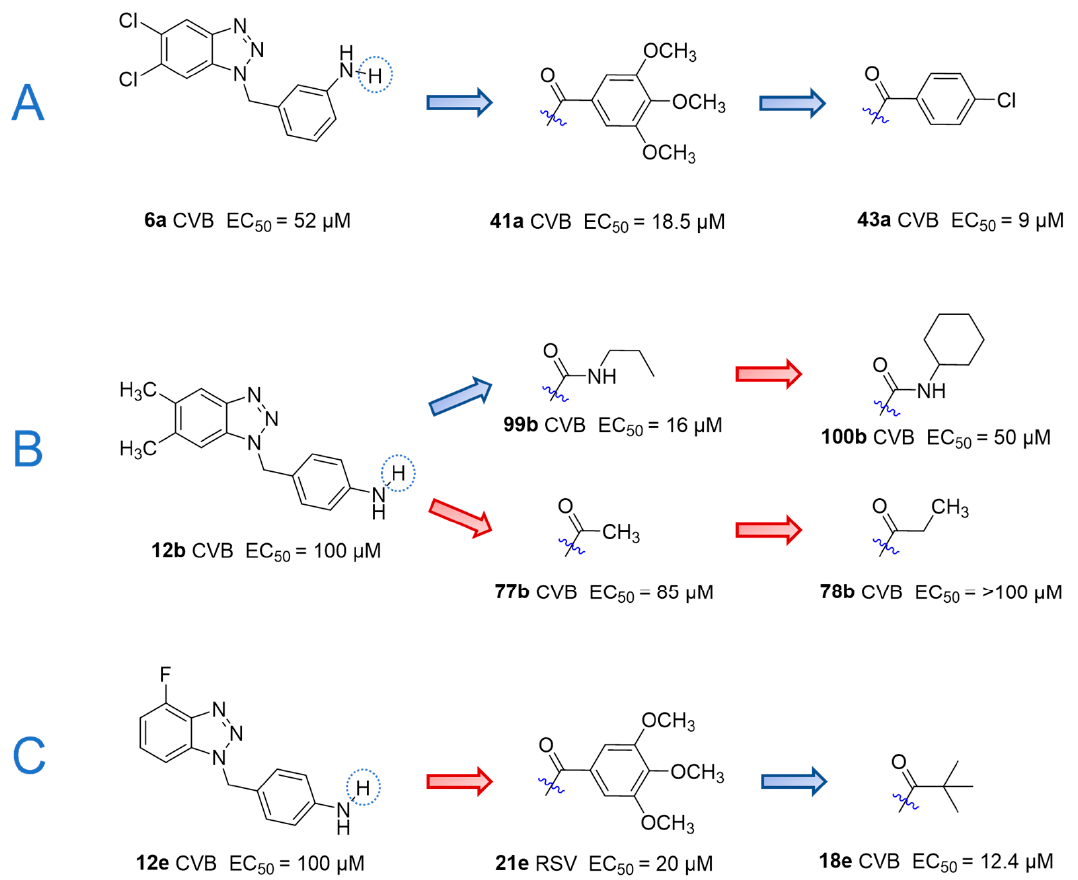
Figure 5. ( A – C ) SARs analysis from the synthetized compounds.